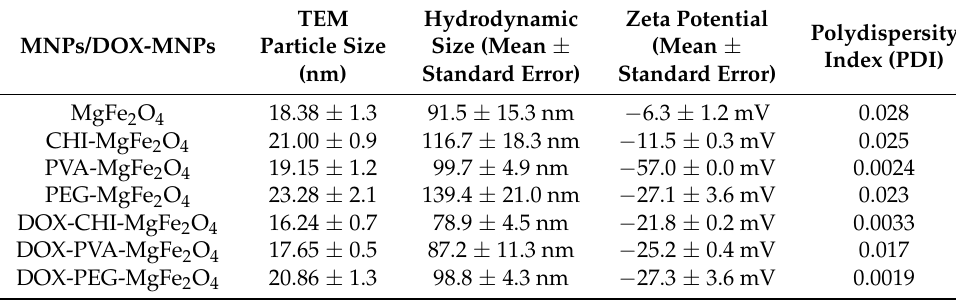
Figure 4. ( A ) TEM micrographs of ( a ) MgFe 2 O 4 , ( b ) CHI-MgFe 2 O 4 , ( c ) PVA-MgFe 2 O 4 , ( d ) PEG- MgFe 2 O 4 , ( e ) DOX-CHI- MgFe 2 O 4 , ( f ) DOX-PVA-MgFe 2 O 4 and ( g ) DOX-PEG-MgFe 2 O 4 . Scale Bar = 100 nm (a-f) and 200 nm (g). ( B ) EDX micrographs for ( a ) MgFe 2 O 4 , ( b ) CHI-MgFe 2 O 4 , ( c ) PVA-MgFe 2 O 4 and ( d ) PEG-MgFe 2 O 4 MNPs.